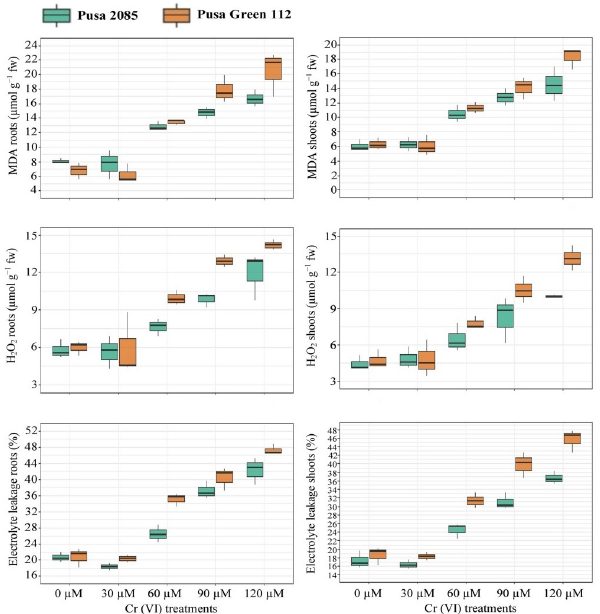
Fig 5. Effects of various chromium (Cr) concentrations on two chickpea varieties (Pusa 2085 and Pusa Green 112). (a) Malondialdehyde (MDA), roots. (b) MDA, shoots. (c) H 2 O 2 , roots. (d) Hydrogen peroxide (H 2 O 2 ), shoots. (e) electrolyte leakage (EL), roots. (f) electrolyte leakage, shoots.